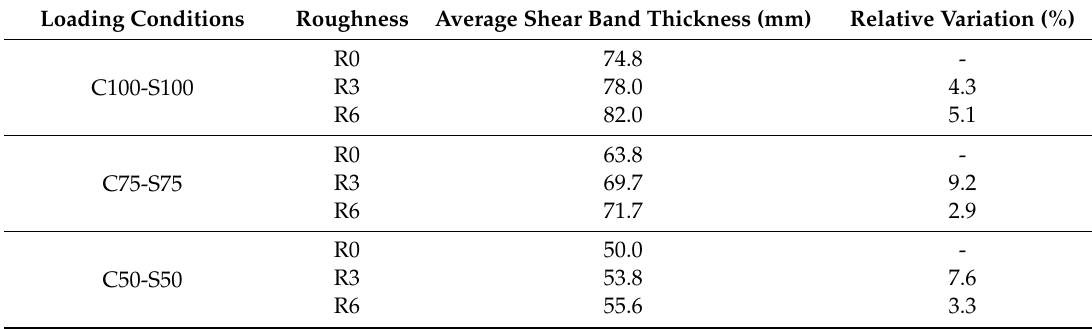
Table 8. Average shear band thickness for specimens with di ff erent roughness values and no grouting Loading Conditions